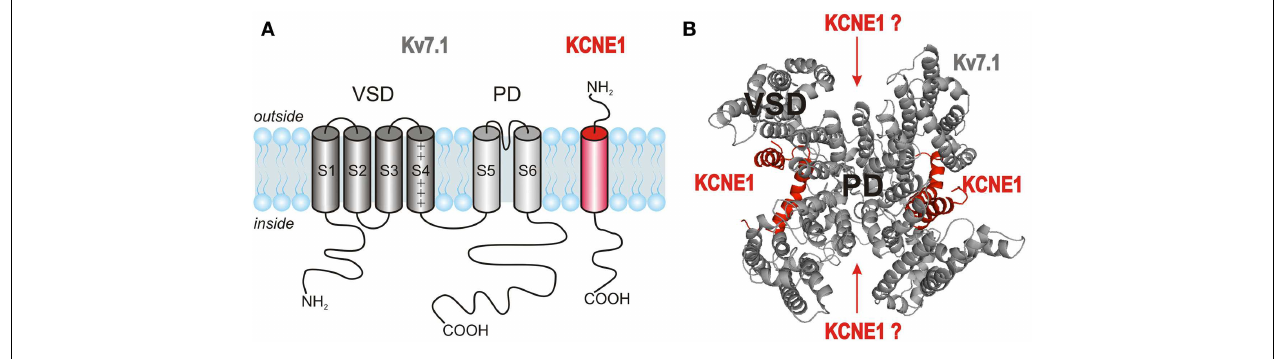
transmembrane segment flanked by an extracellular N-terminus and a cytosolic C-terminus. (B) Four Kv7.1 α -subunits assemble to form a functional channel.The number of KCNE1 β -subunits associating with Kv7.1 tetramers is still a matter of extensive debate (Strutz-Seebohm et al.,